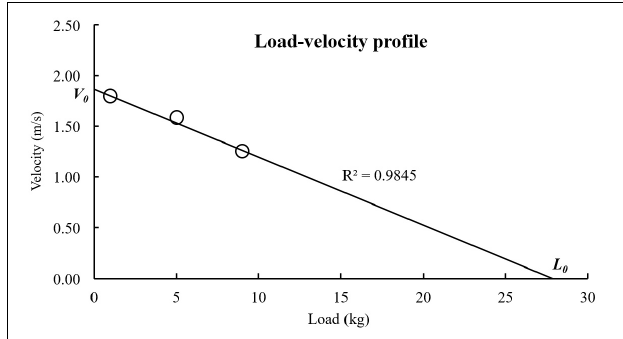
FIGURE 3 | An example of a load-velocity profile (obtained from one subject tested in the current